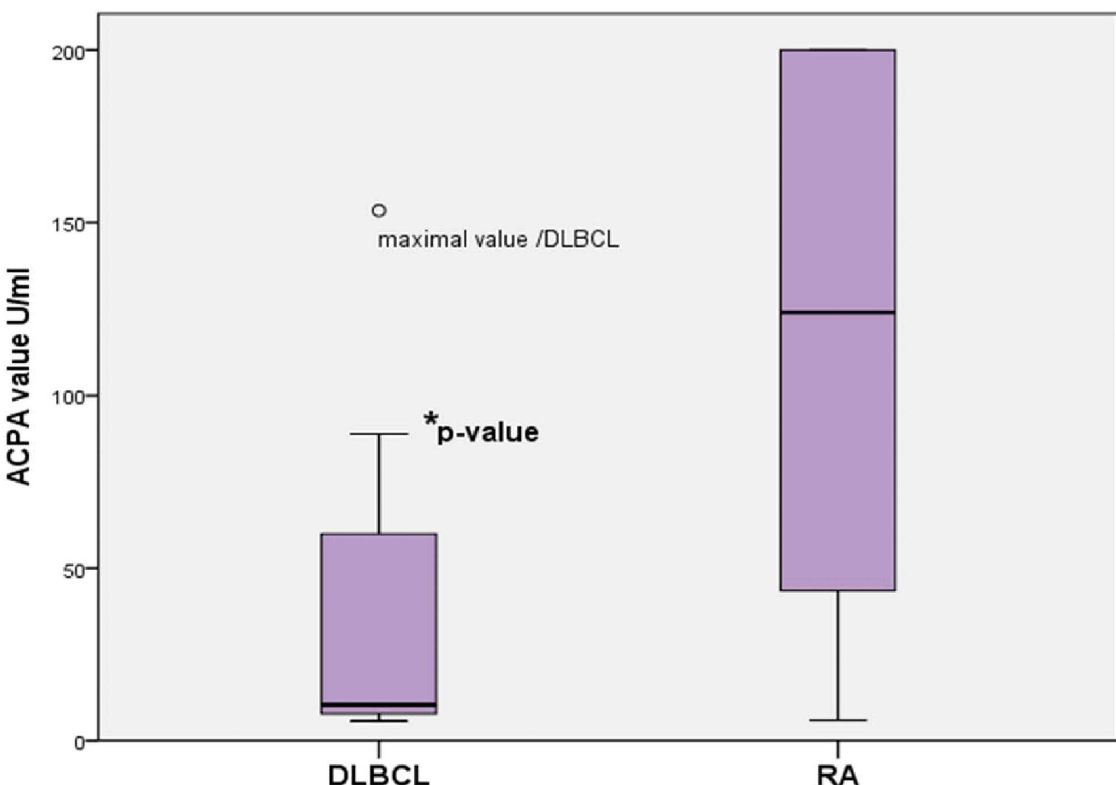
Figure 2. Boxplots presenting results of ACPA serum concentration levels in DLBCL (n=14) and RA (n=175). Boxplots with median (10.4 versus 124.1) and first/third quartile, respectively. ACPA 2 / + =anti-citrullinated cyclic peptide positive/negative. DLBCL=diffuse large B-cell non- Hodgkin lymphoma patients. *p-value=0.0001.